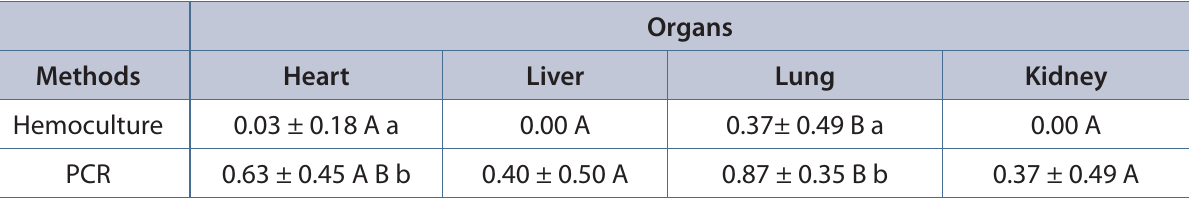
Table 5. Comparison between organs and methods (hemoculture and PCR analysis) for BALB/c mice infected with T. cruzi